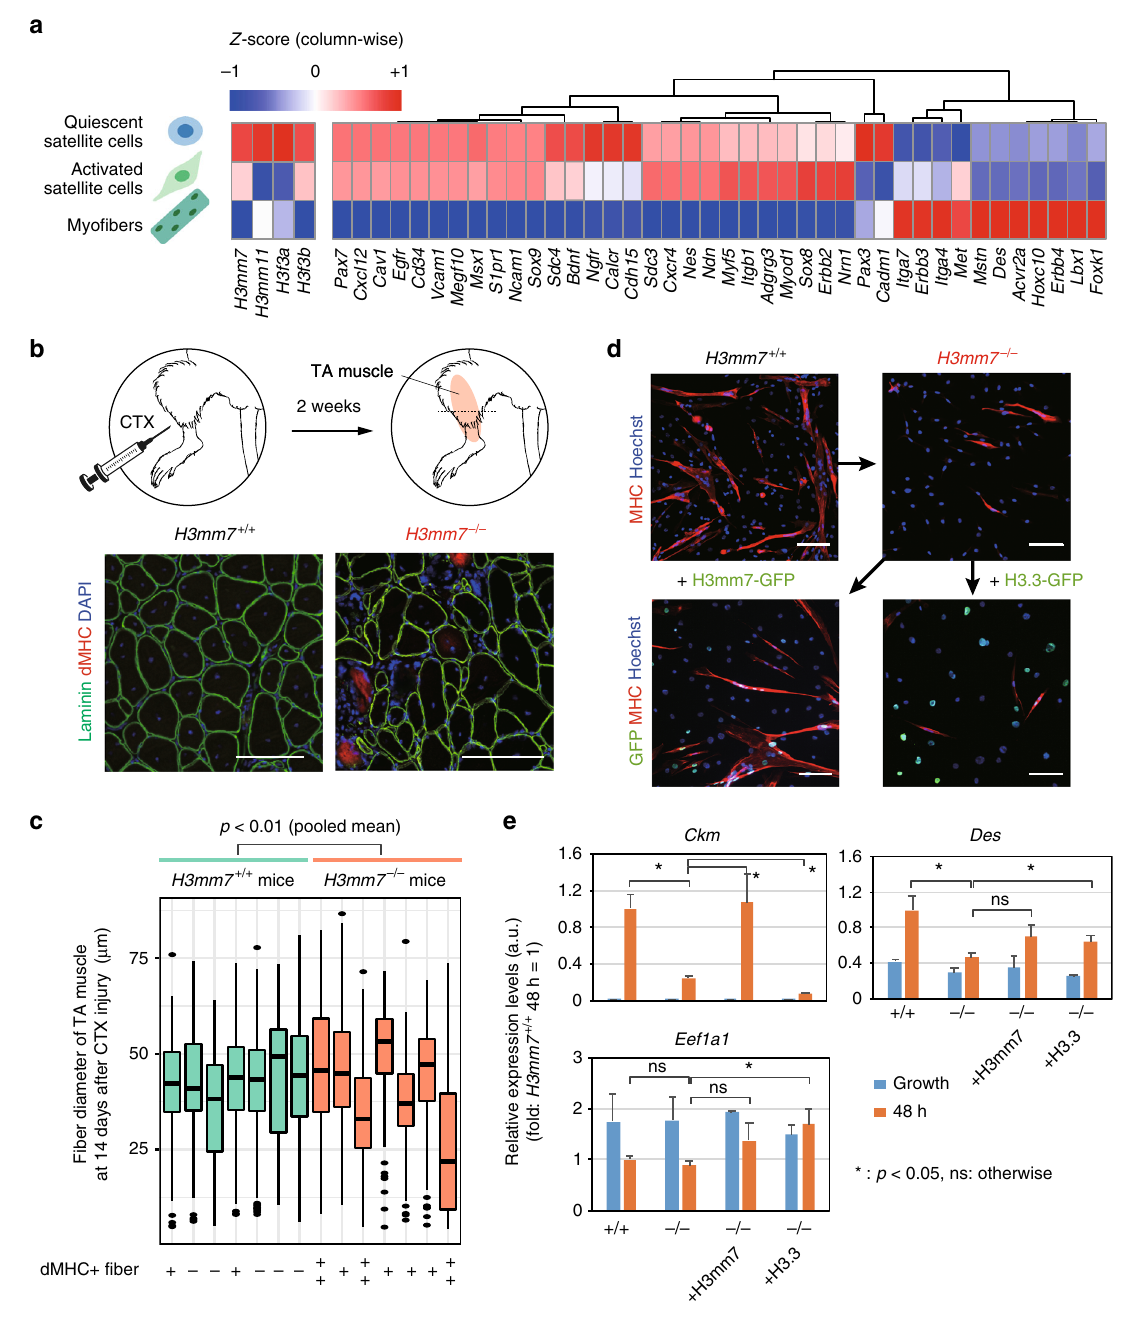
Fig. 1 H3mm7 is required for normal skeletal muscle regeneration and differentiation. a The H3mm7 gene is expressed in satellite cells. The colors of the tiles indicate the average expression level ( n = 3) of H3 variants, satellite cell marker genes, and differentiation markers 45 as the column-wise relative expression levels ( Z -score). b Some of the fi bers showed incomplete muscle regeneration in H3mm7 − / − mice. Immunostaining of a regeneration